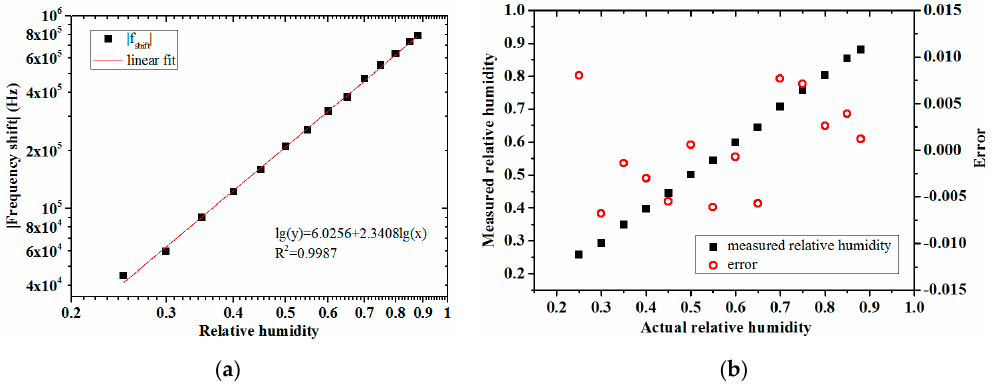
Figure 8. Analysis of the presented sensor’s response to relative humidity: ( a ) linear fit between lg( f shift ) and lg(RH); ( b ) the measurement error.